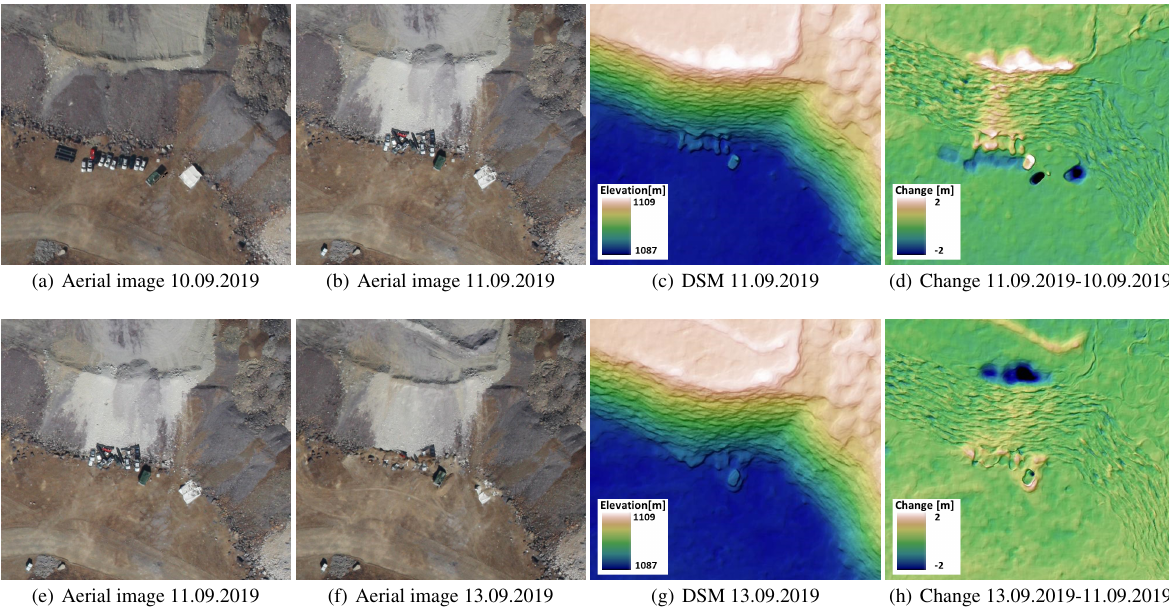
Figure 4. Aerial imagery, DSMs and 3D differences of an artificial landslide visualizing single events during IRONORE2019. (a) to (d) illustrate the movement of vehicles and provision of filling material between 10.09.2019 and 11.09.2019 using orthoimages, DSM and differences of the DSMs. (e) to (h) visualize material slid down between 11.09.2019 and 13.09.2019.